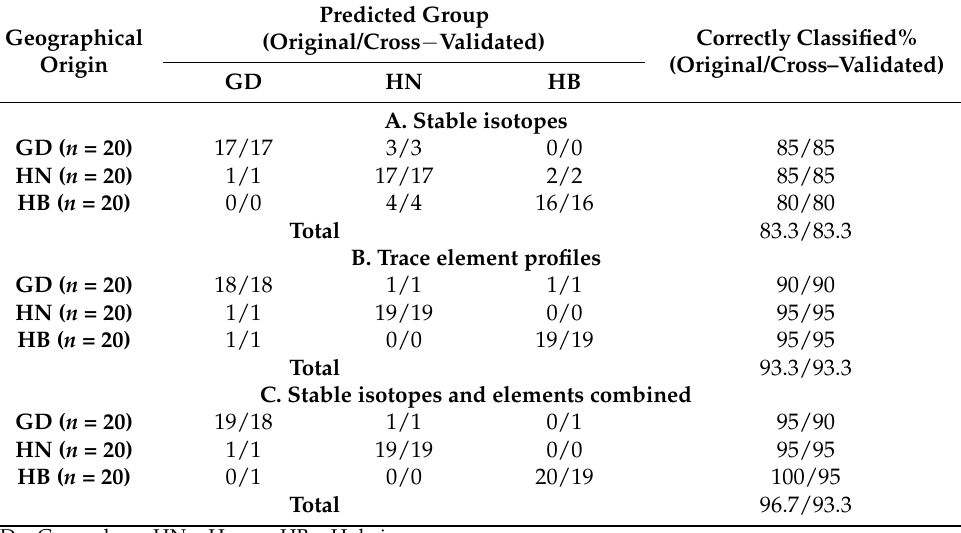
Table 4. Linear discriminant analysis of stable isotope and/or trace element profiles of P. clarkii from different geographic origins.